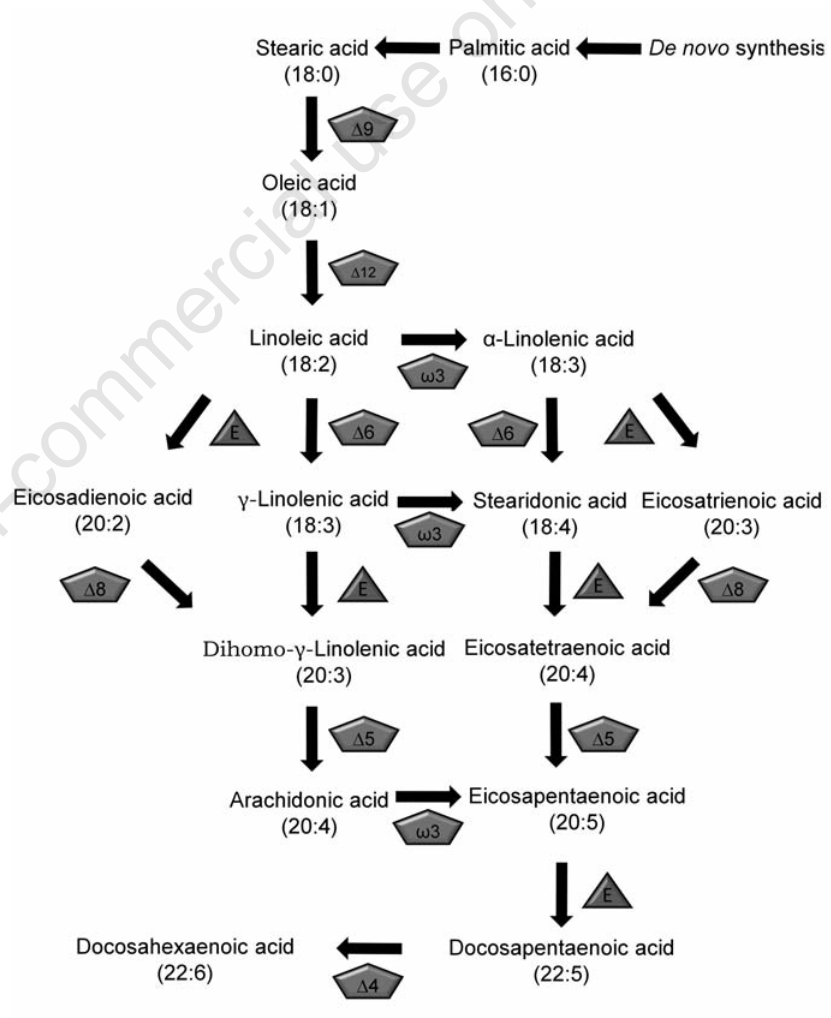
Figure 5. Very-long-chain polyunsaturated fatty acid (VLC-PUFA) biosynthesis in eukaryotic algae. Pentagons and triangles represent desaturases and elongases enzymes involved in algal VLC-PUFA biosynthesis, respectively. Adapted from Harwood and Guschina.